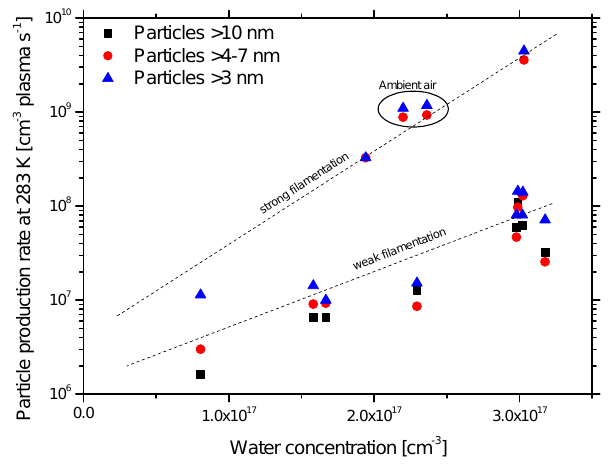
Fig. 8. Formation rates for particles of different sizes in the laser plasma in humid synthetic air at 283K for water concentrations be- tween 8 × 10 16 and 3 × 10 17 cm − 3 . Two experiments with ambient air (cf. Sect. 3.4) are added for comparison. Dashed lines are just to guide the eyes to the results for pure humid air for the two filamen- tation